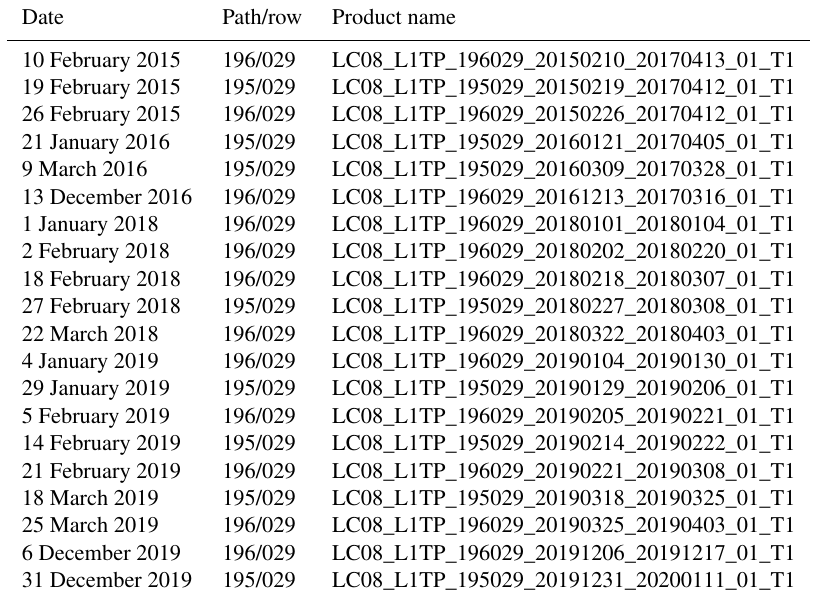
Table C1. List of selected